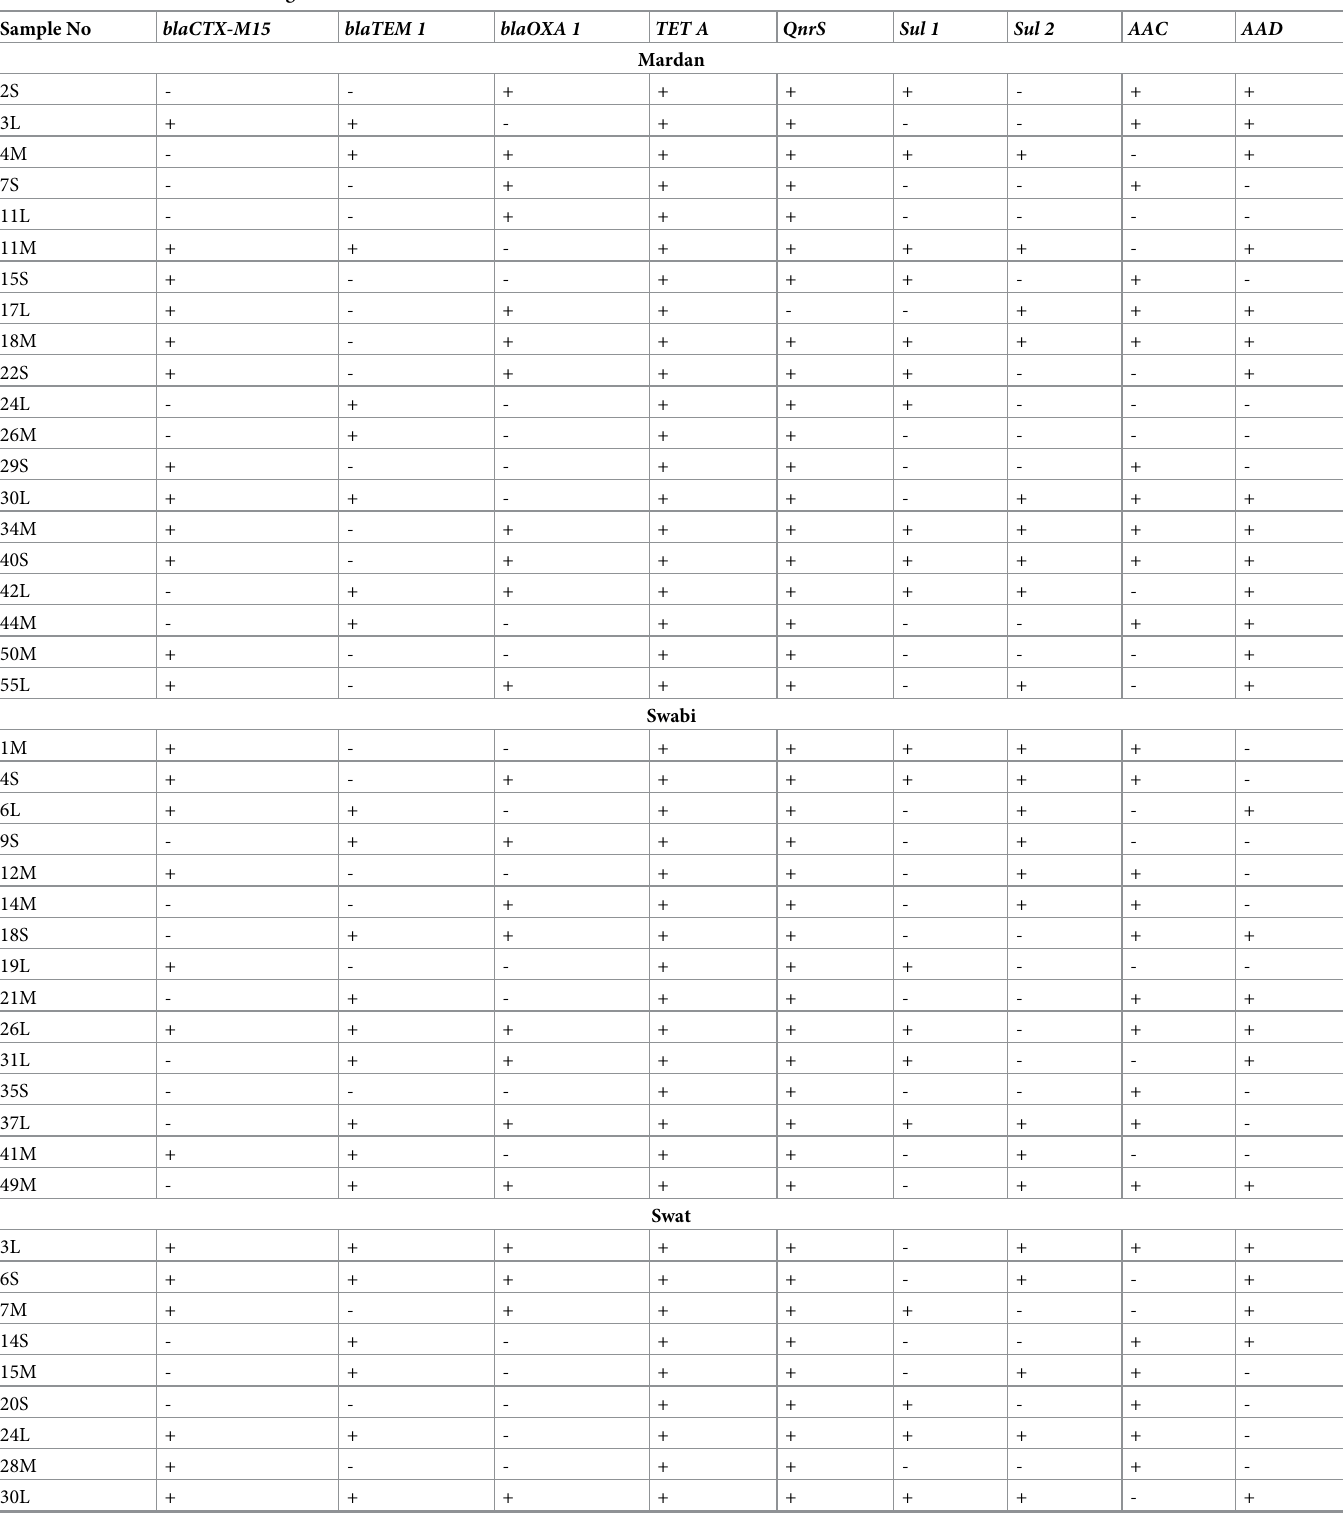
Table 6. No of antibiotic resistant genes in E . coli